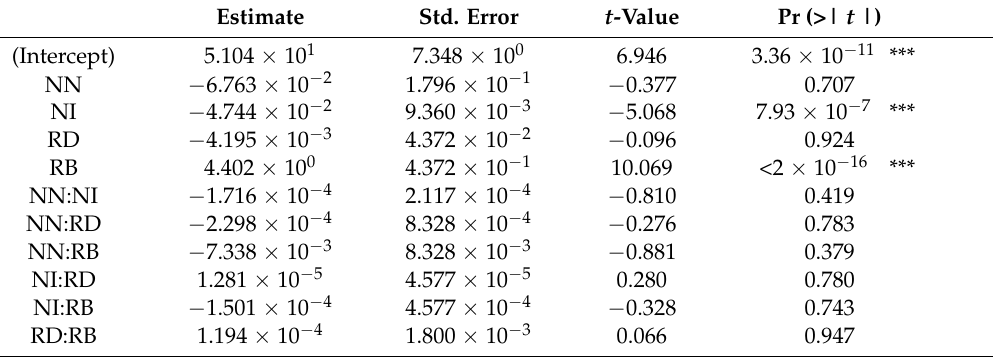
Table 3. Model 1 (ANOVA